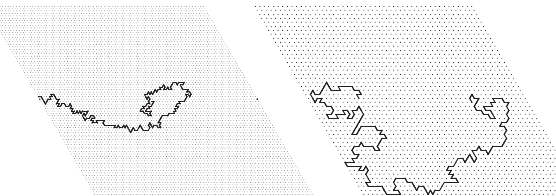
FIG. 10. String of shifted dimers connecting monomers in the random dimer model. The optimal dimer coverings in the random-energy dimer model, computed for the full lattice and for a lattice with a pair of monomer defects, is the same everywhere except along a string connecting the two monomer sites: along the string all dimers are shifted by one. Here we show sample plots of these strings, for fixed defects ( L ¼ 80 , left) and optimized defects ( L ¼ 64 , right). The string fractal dimension is 1 . 28 ð 1 Þ for the triangular lattice and d computed to be d f ¼ f ¼ 1 . 25 ð 1 Þ for the square